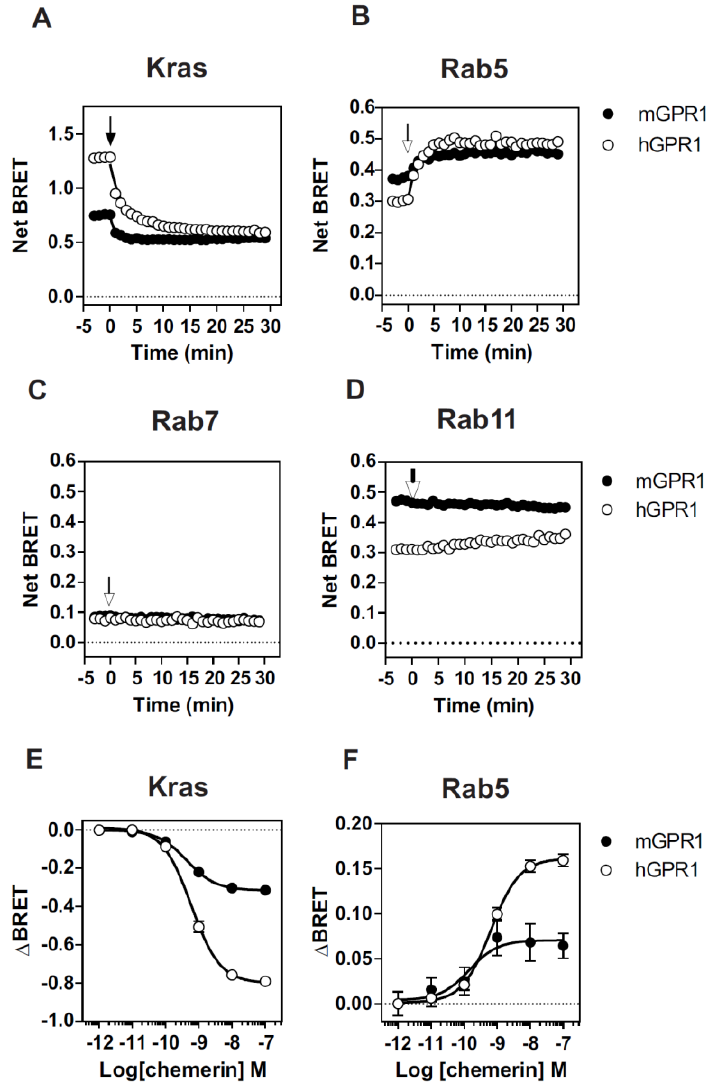
Figure 2. Cellular distribution and internalization of GPR1: ( A – D ) real-time measurement of BRET signal in HEK293T cells expressing hGPR1- R Luc ( ○ ) or mGPR1- R Luc ( ● ) in combination with KRas- Venus (plasma membrane) ( A ), Rab5-Venus (early endosomes) ( B ), Rab7-Venus (late endosomes) ( C ) or Rab11-Venus (recycling endosomes) ( D ) in basal conditions and after stimulation with 100 nM chemerin. Results are expressed as Net BRET corresponding to the BRET signal measured between the donor and the acceptor minus the BRET signal measured with the donor only; ( E , F ) real-time measurement of BRET signal in cells expressing hGPR1- R Luc ( ○ ) or mGPR1- R Luc ( ● ) in combination with KRas-Venus ( E ) or Rab5-Venus ( F ) measured 30 min after the simulation with increasing concentrations of chemerin. Results are expressed as Δ BRET corresponding to the difference between the BRET signal measured before and after stimulation with chemerin. Data represent the mean ± SEM of at least three independent experiments.